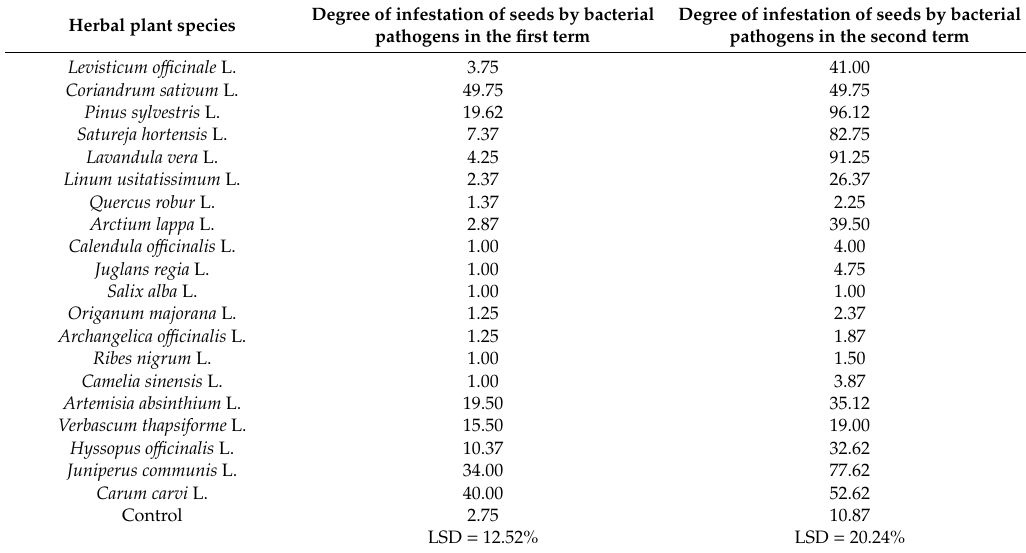
Table 4. Influence of herbal plant species on bacterial contamination of seeds (%). Degree of infestation of seeds by bacterial Degree of infestation of seeds by bacterial Herbal plant species pathogens in the first term pathogens in the second term Levisticum o ffi cinale L.